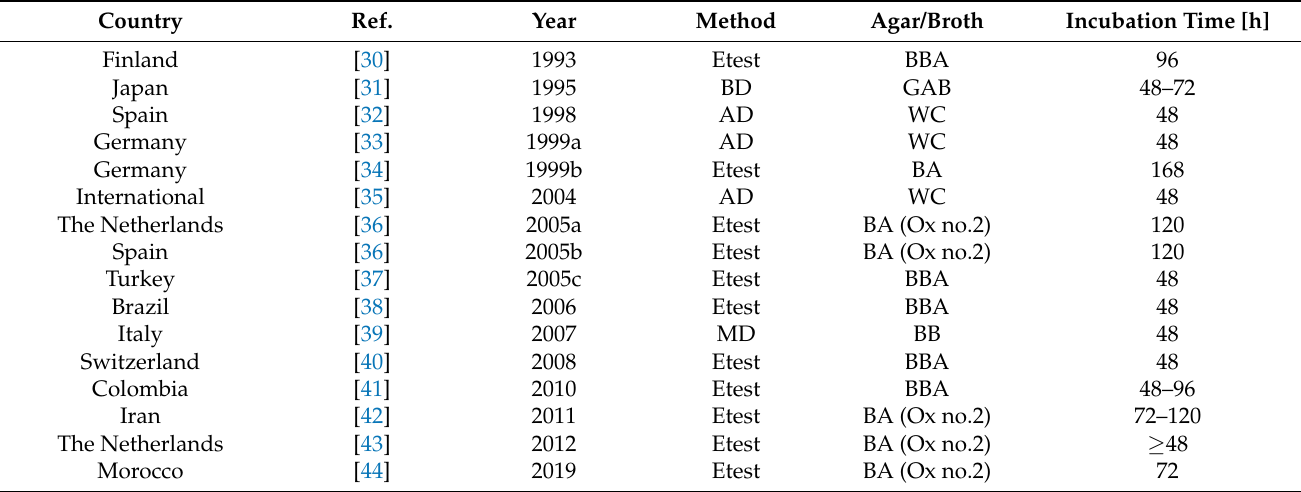
Table 4. Culture conditions used for MIC determination of Porphyromonas gingivalis